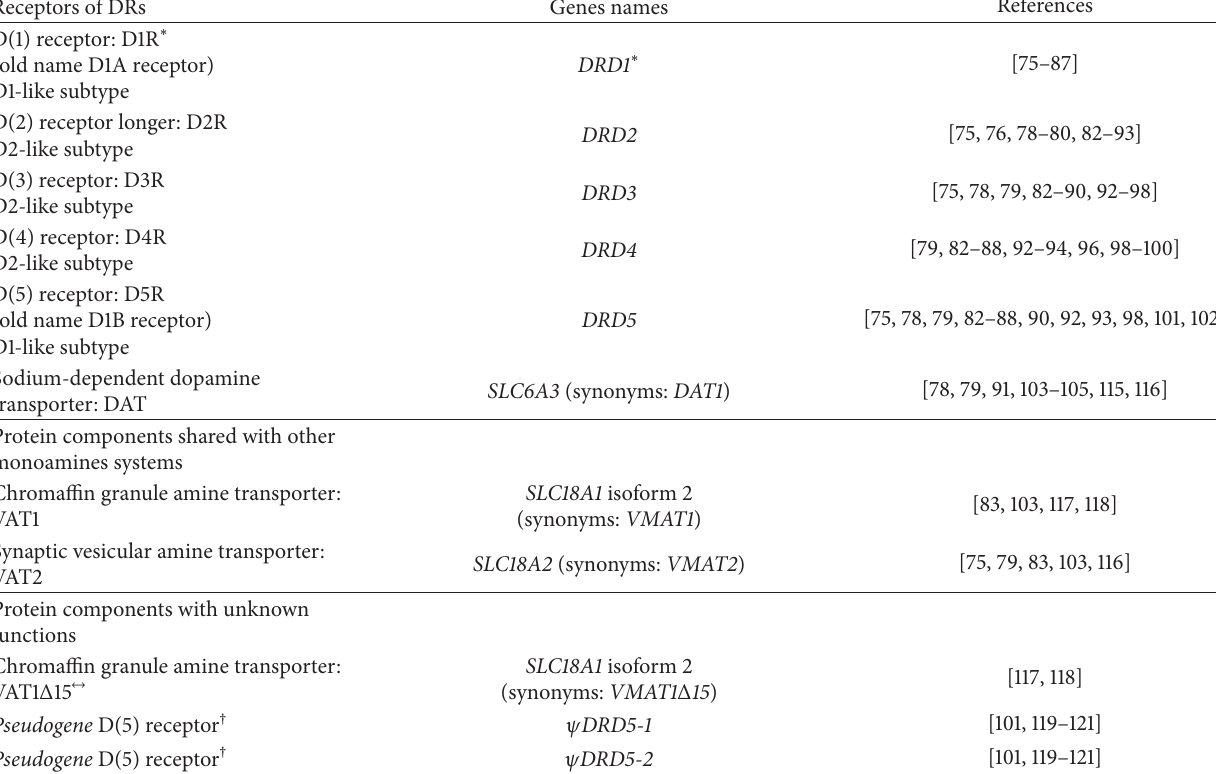
Table 2: Dopaminergic system protein components expressed in immune